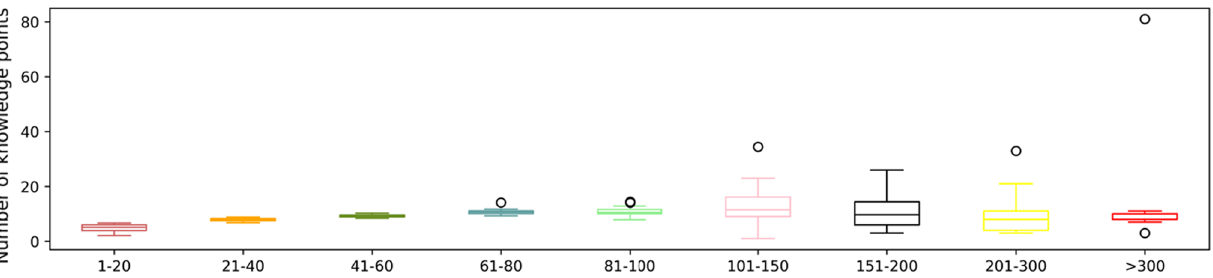
Fig. 7 The average number of knowledge points contained in the problems involved in different sessions